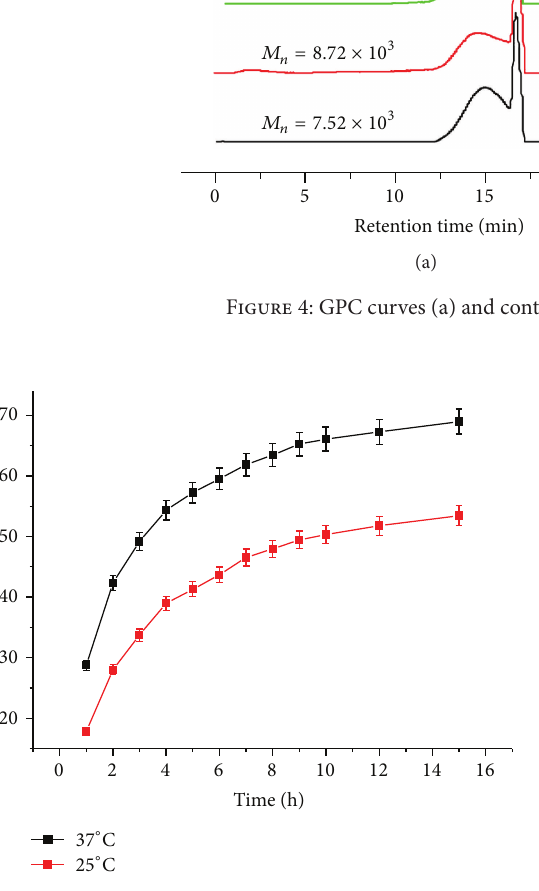
Figure 6: The accumulative release of ibuprofen from polyesters (PIGH and